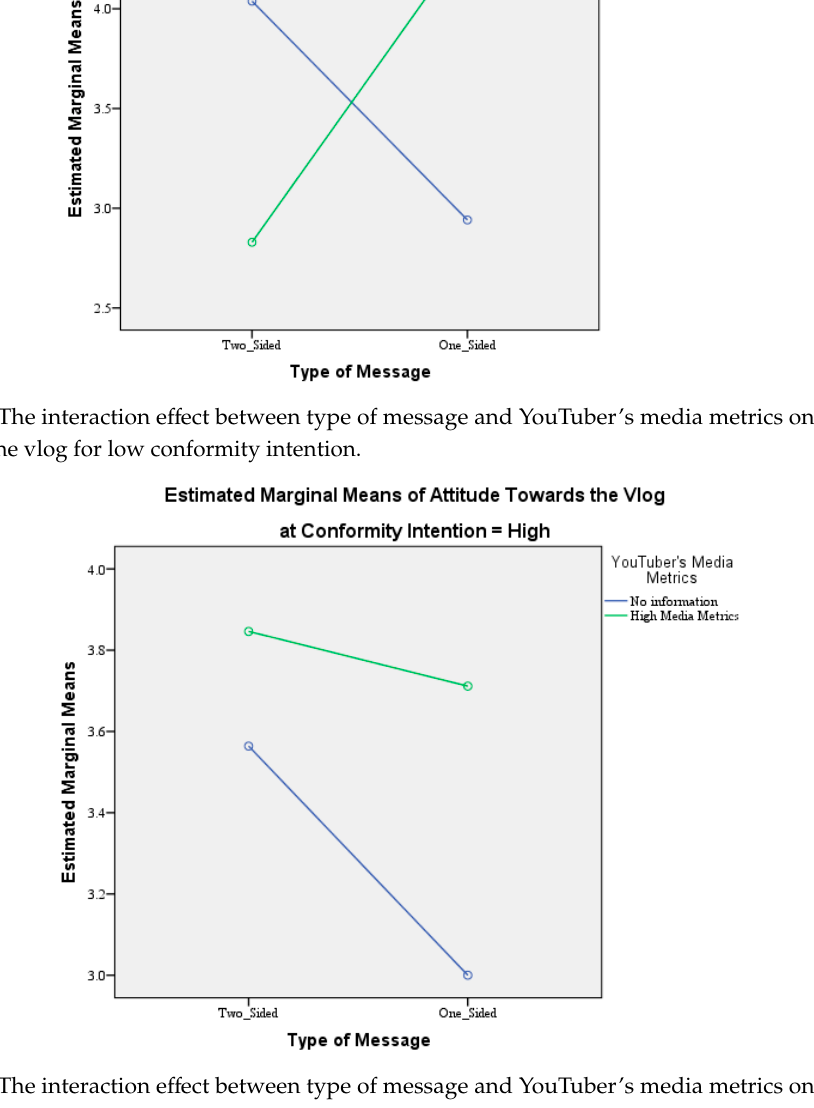
Figure 4. The interaction effect between type of message and YouTuber’s media metrics on attitude towards the vlog for high conformity intention.